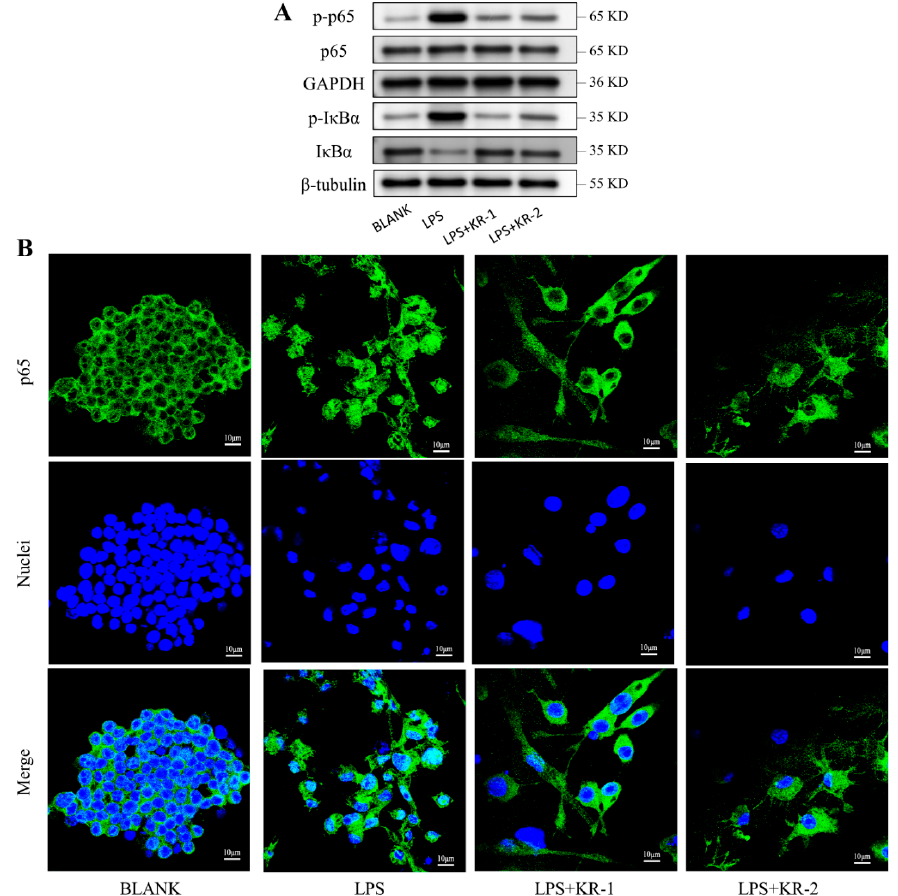
Figure 6. ( A ) Expression levels of NF- κ B signaling pathway-related proteins: p65, p-p65, I κ B α , and p-I κ B α . ( B ) CLSM images of p65 in RAW264.7 cells after different treatments. Green (p65); blue